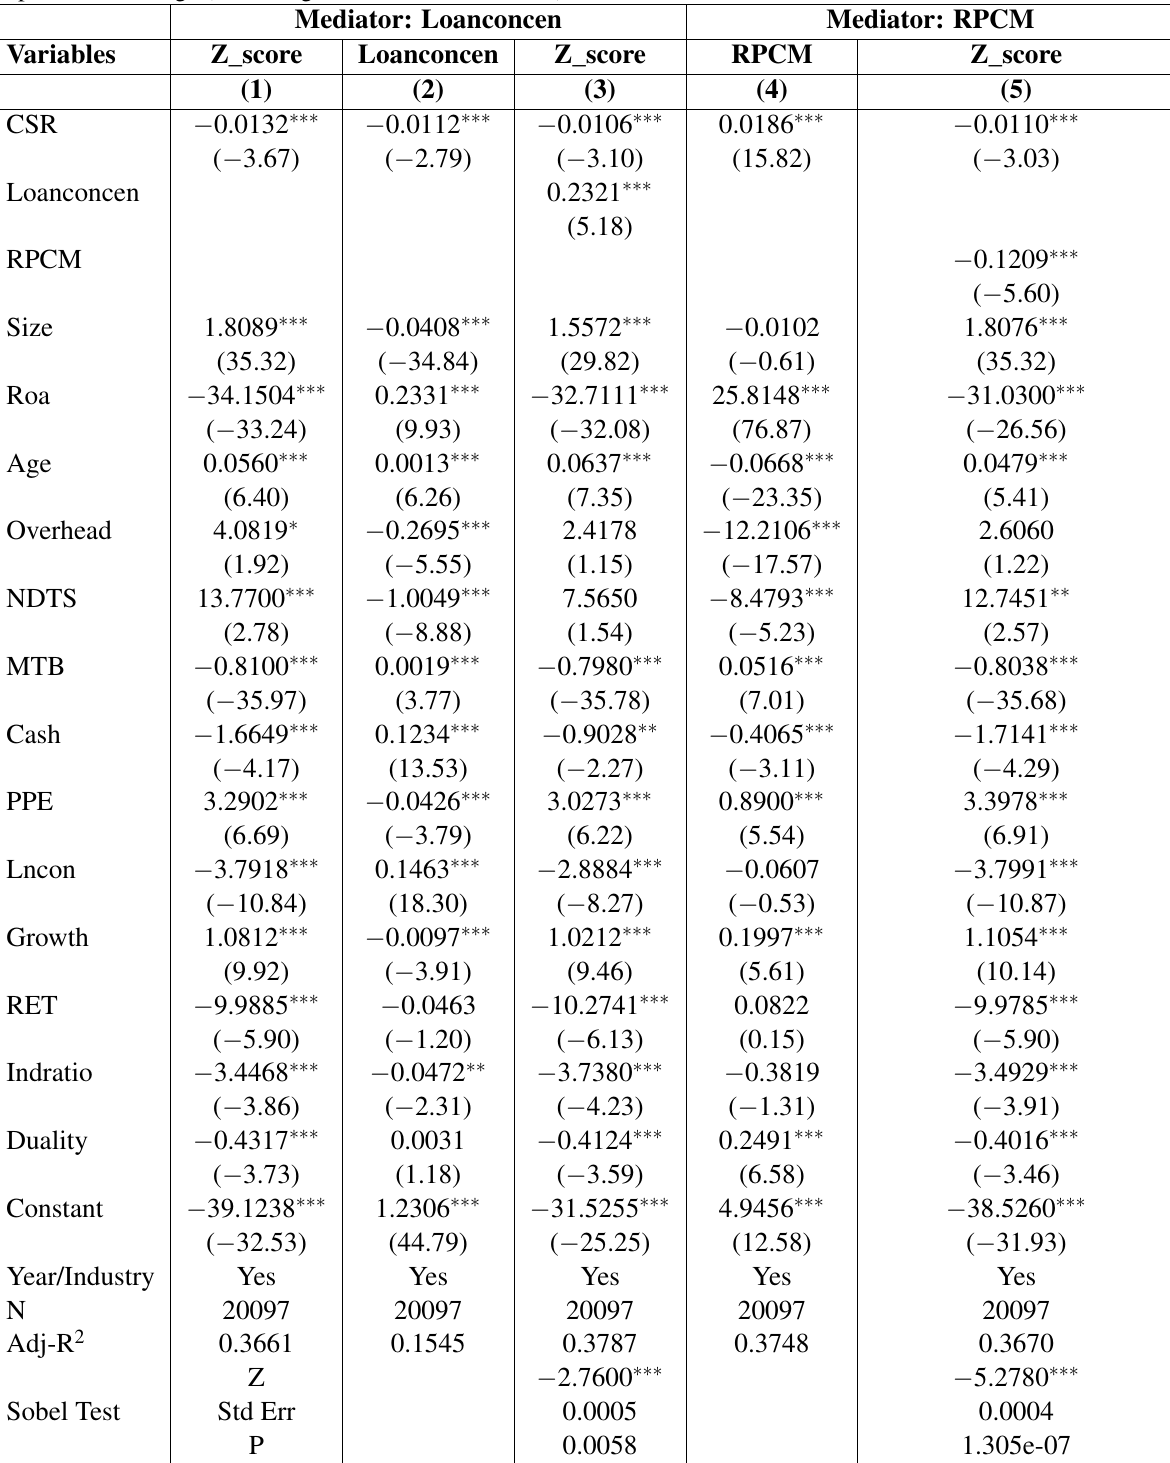
Table 3 CSR fulfillment and debt risk: based on the mediating effect test of debt concentration and product market competitive advantage (take a negative number of